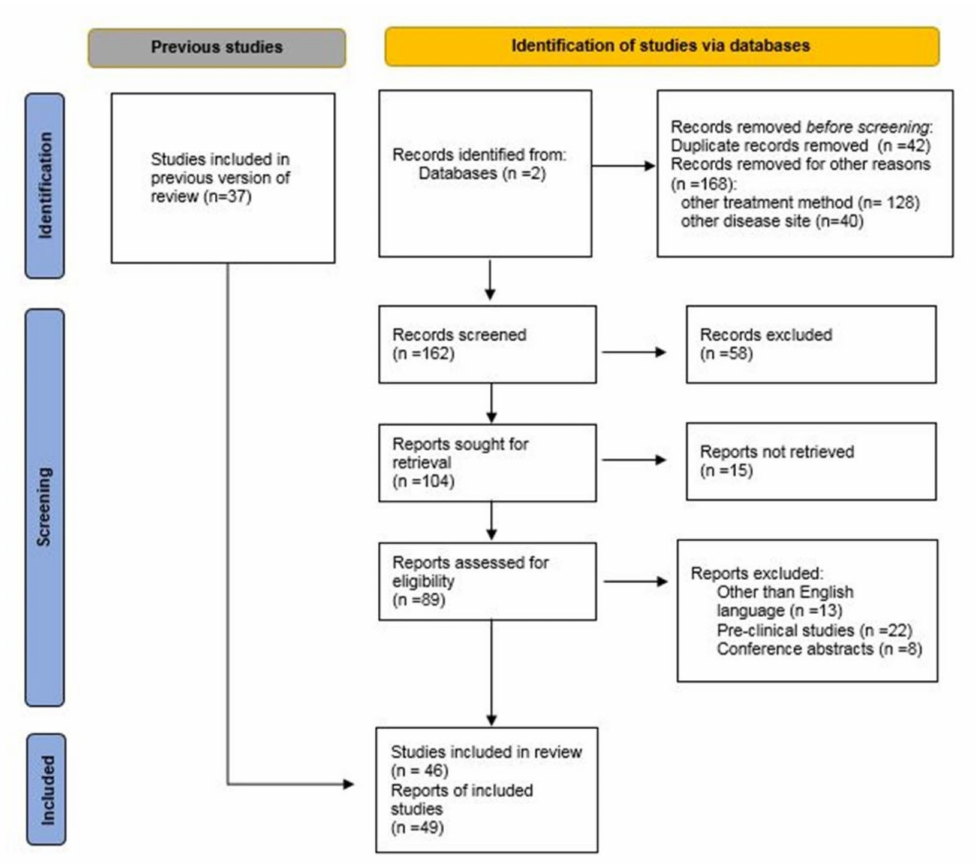
Figure 1. PRISMA flow diagram for the review which includes searches of